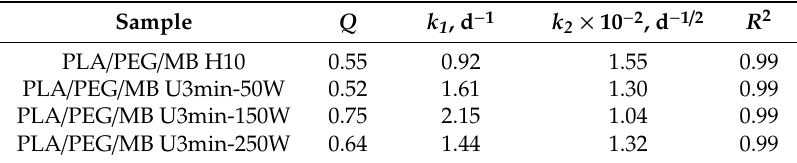
Figure 8. Kinetics analysis for the release of MB from PLA / PEG (65 / 35) blends with di ff erent ultrasound intensity. Table 6. E ff ect of ultrasound on kinetics parameter, Q , erosion release constant, k 1 , and di ff usion release constant, k 2 , and correlation coe ffi cients, R 2 , for MB released from PLA / PEG